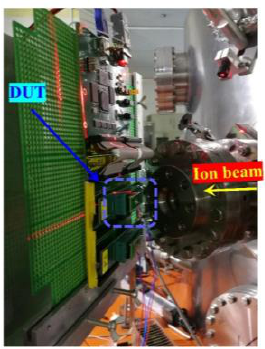
Figure 3. DUT in the terminal of the heavy-ion beamline. Table 1. Ion spices, energy, LET, and range in silicon.